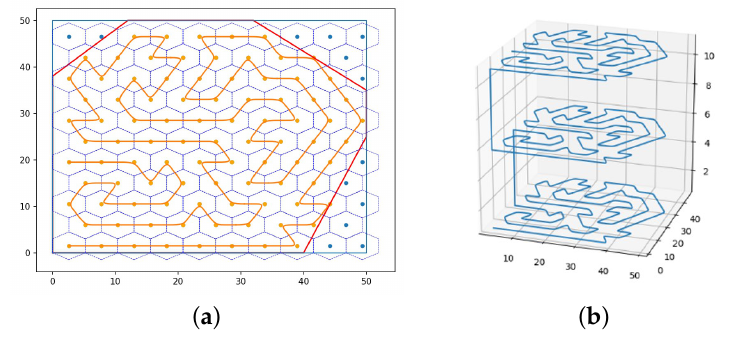
Figure 6. ( a ) Subspace path fitting result; ( b ) 3D detection